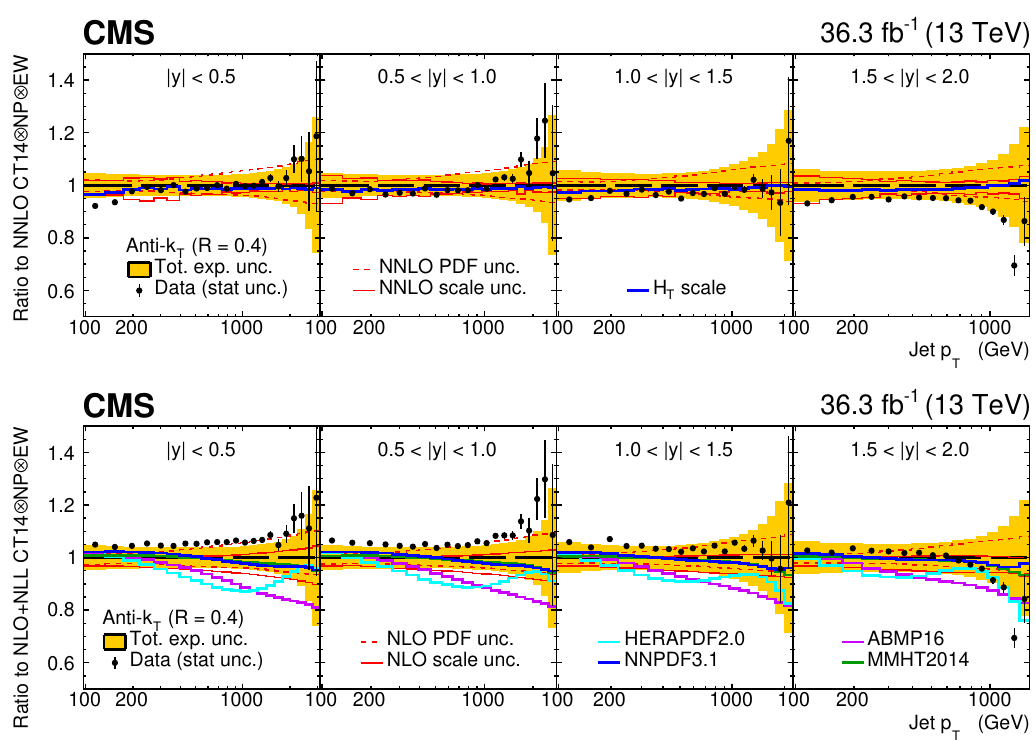
Figure 7 . The double-differential cross section of inclusive jet production, as a function of p T and | y | , for jets clustered using the anti- k algorithm with R = 0 . 4 , presented as ratios to the T QCD predictions. The data points are shown by filled circles, with statistic uncertainties shown by vertical error bars, while the total experimental uncertainty is centred at one and is presented by the orange band. In the upper panel, the data are divided by the NNLO prediction, corrected for NP and EW effects, using CT14nnlo PDF and with renormalisation and factorisation scales jet p and, alternatively H (blue solid line). In the lower panel, the data are shown as ratio to T T NLO+NLL prediction, calculated with CT14nlo PDF, and corrected for NP and EW effects. The scale (PDF) uncertainties are shown by red solid (dashed) lines. NLO+NLL predictions obtained with alternative PDF sets are displayed in different colours as a ratio to the central prediction using